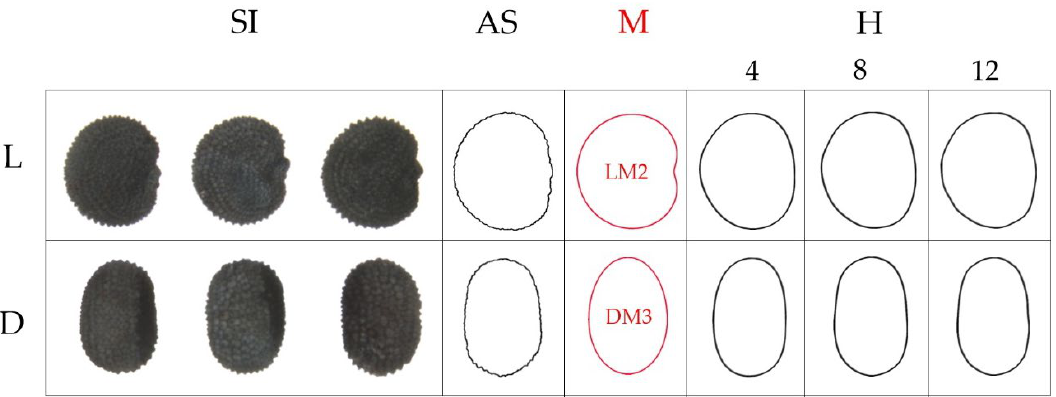
Figure 11. Silhouettes of seeds of S. dioica Pol. L: Lateral view; D: Dorsal view; SI: Seed image; AS: Average silhouette of 20 seeds; M: Models calculated LM2 and DM3; H: Curves obtained by Fourier equations with 4, 8, and 12 harmonics.